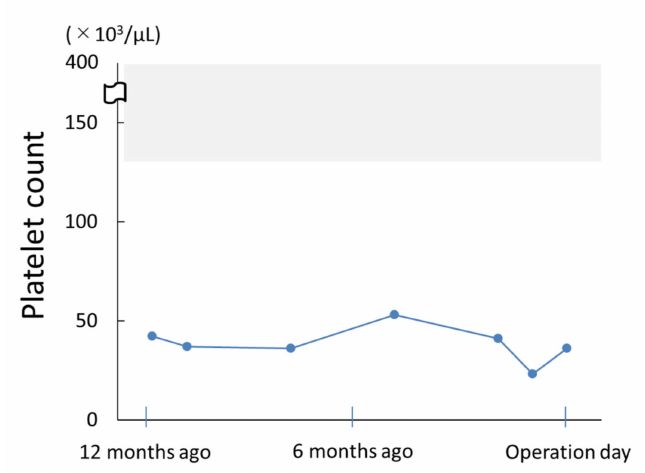
Figure 2. Platelet counts in the year leading up to the surgery. The gray color indicates the standard value for healthy subjects.